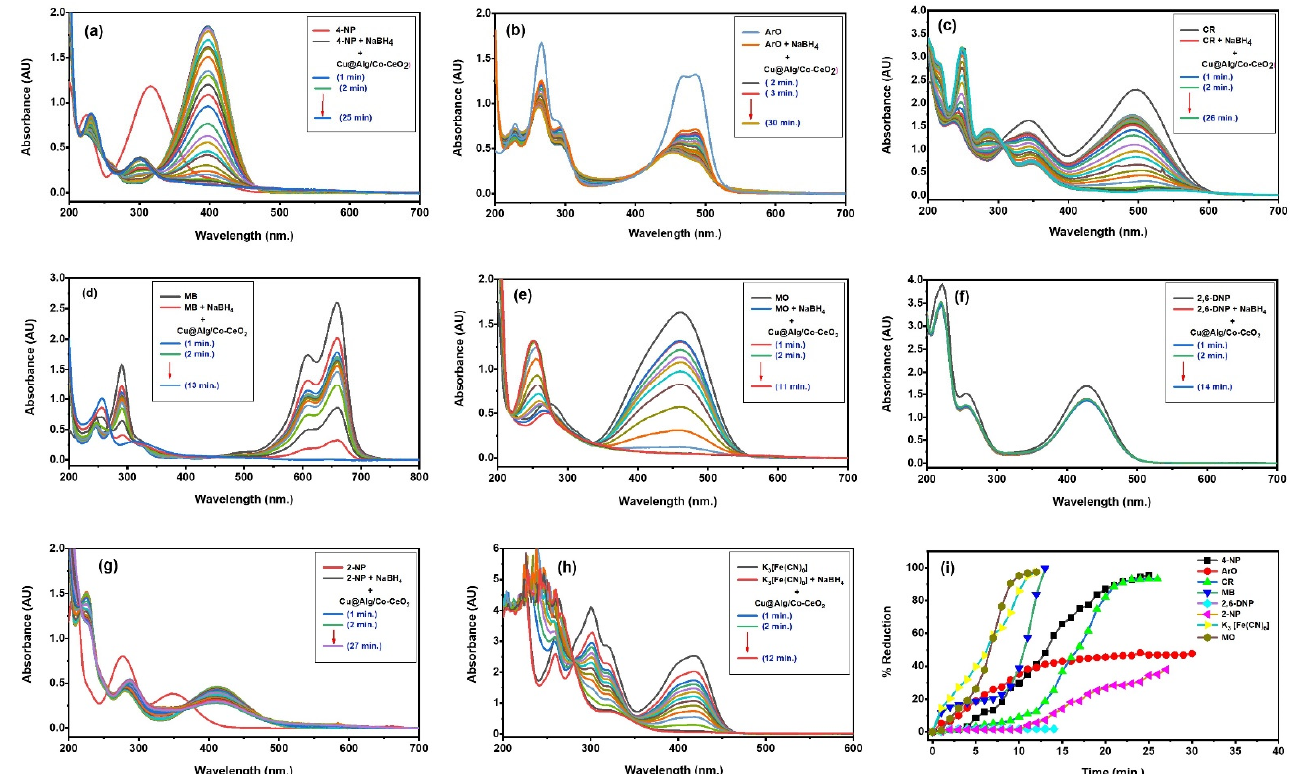
Figure 3. UV–vis absorption spectra for the reduction of pollutants: ( a ) 4-NP (0.13 mM), ( b ) ArO (0.07 mM), ( c ) CR (0.07 mM), ( d ) MO (0.07 mM), ( e ) MB (0.07 mM), ( f ) 2,6-DNP (0.13 mM), ( g ) 2-NP (0.13 mM), and ( h ) K 3 [Fe(CN) 6 ] (0.5 mM)] using 0.5 mL NaBH 4 (0.1 M) and Cu@Alg/Co–CeO 2 catalyst (4 beads). ( i ) % Reduction of pollutants as a function of time.